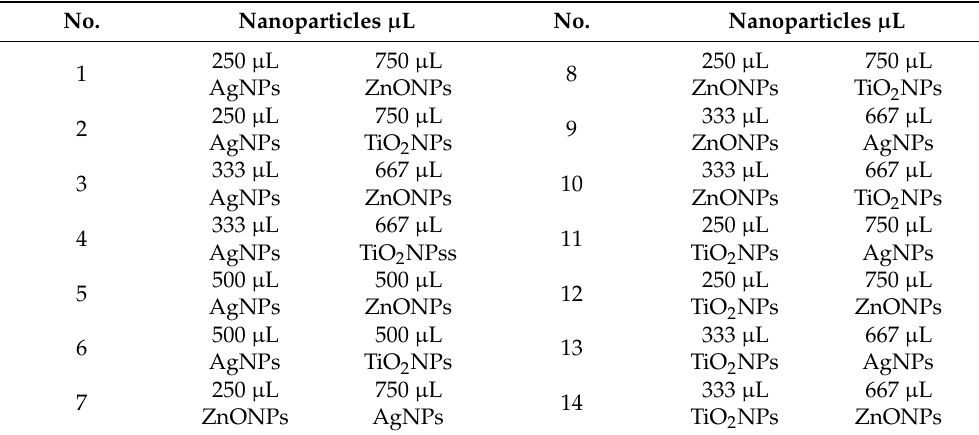
Table 1. Mixed ratio nanocomposite (v/v) between Ag, ZnO and TiO 2 nanoparticles. No. Nanoparticles µ L No. Nanoparticles µ